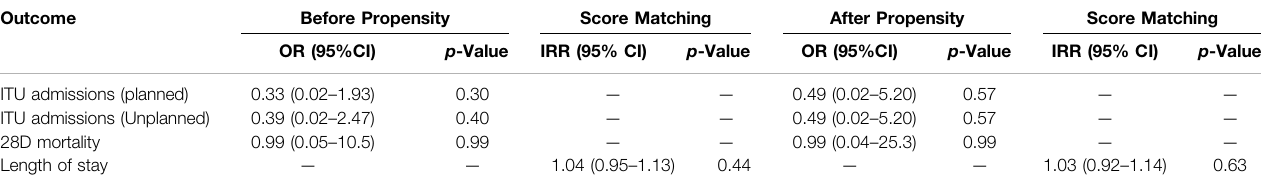
TABLE 3 | Summary of outcome measures before and after propensity score